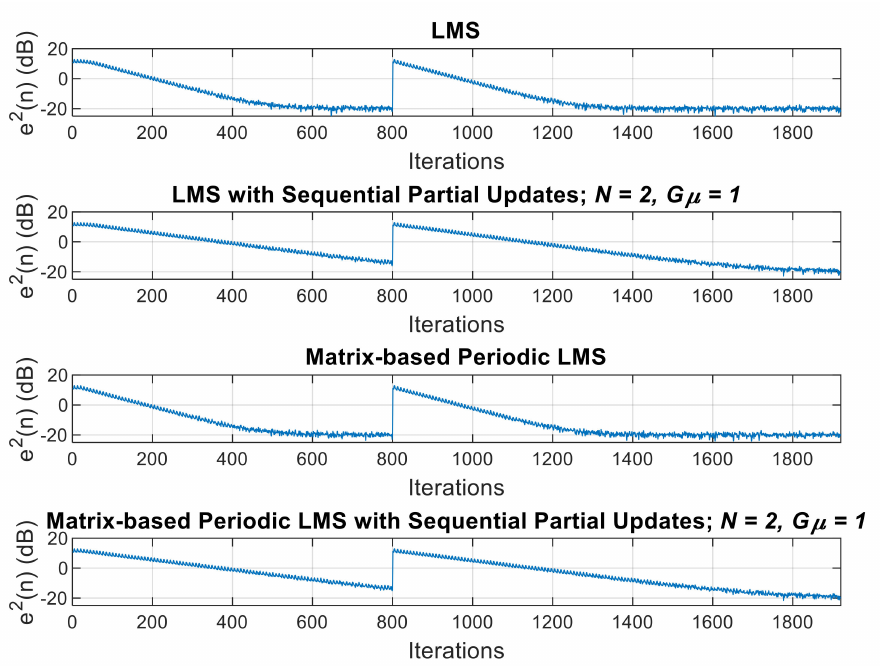
Figure 10. Learning curves comparison. Version 1 of the experiment: desired signal d 1 ( n ) and reference signal x 1 ( n ) . ( a ) LMS, ( b ) LMS with Seq PU; N = 2 and G µ = 1, ( c ) P-LMS, ( d ) P-LMS with Seq. PU; N = 2 and G µ = 1. Average of 50 runs. The performance measure used is the instantaneous squared error in logarithmic scale (dB).